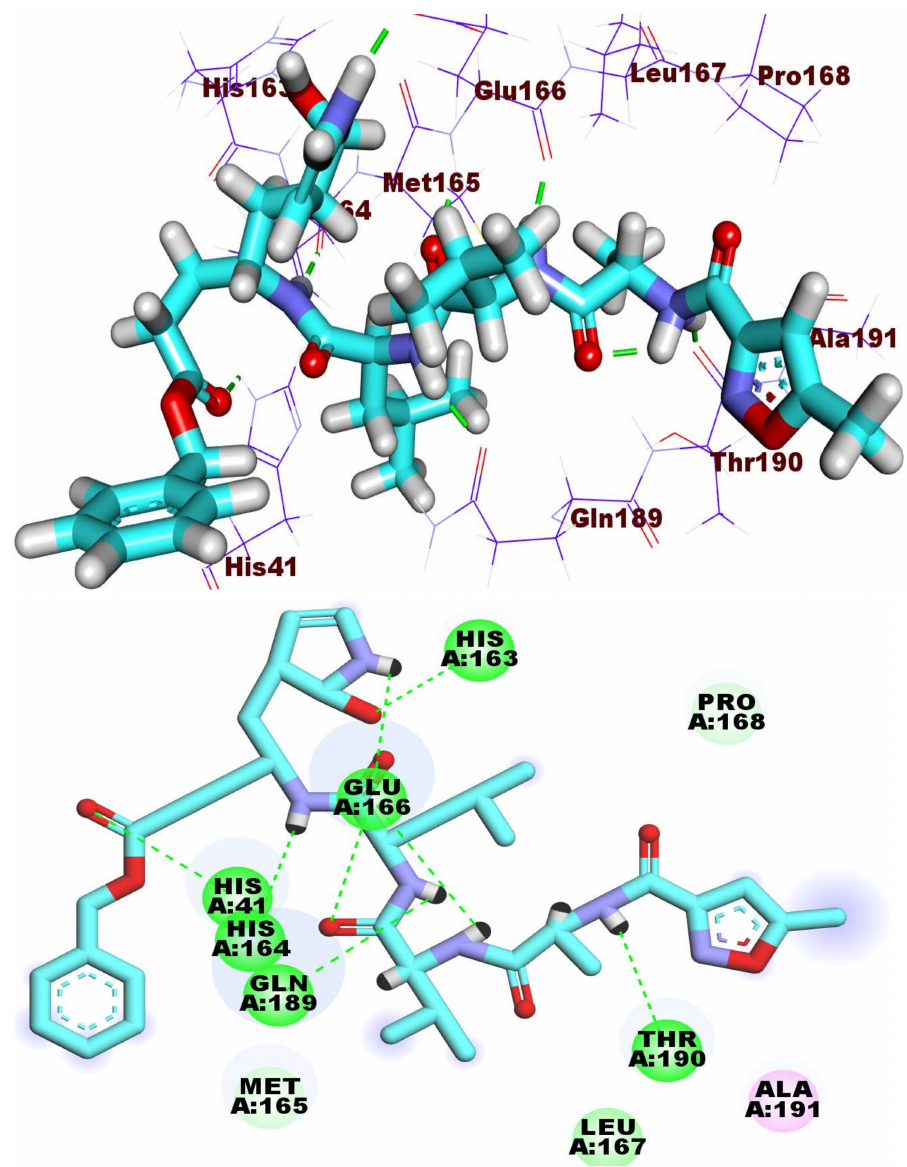
Figure 5. The binding pattern of PRD_002214 inside the 6LU7 active site of M pro PDB ID: 6LU7 active